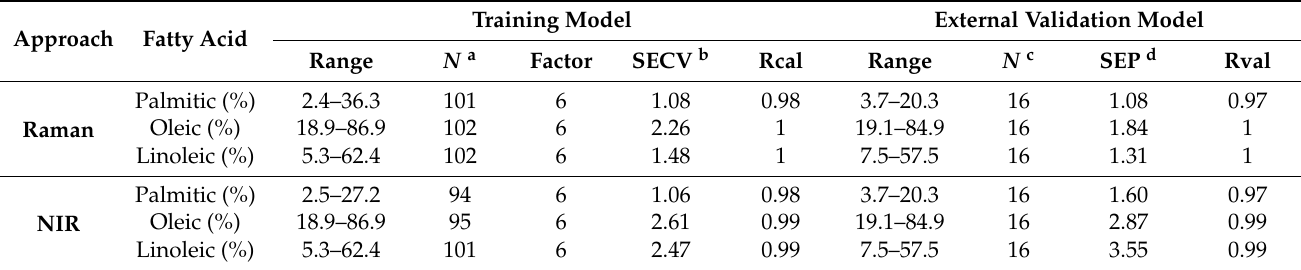
a Sample number in the training models. b Standard error of cross validation. c Sample number in the external validation models. d Standard error of